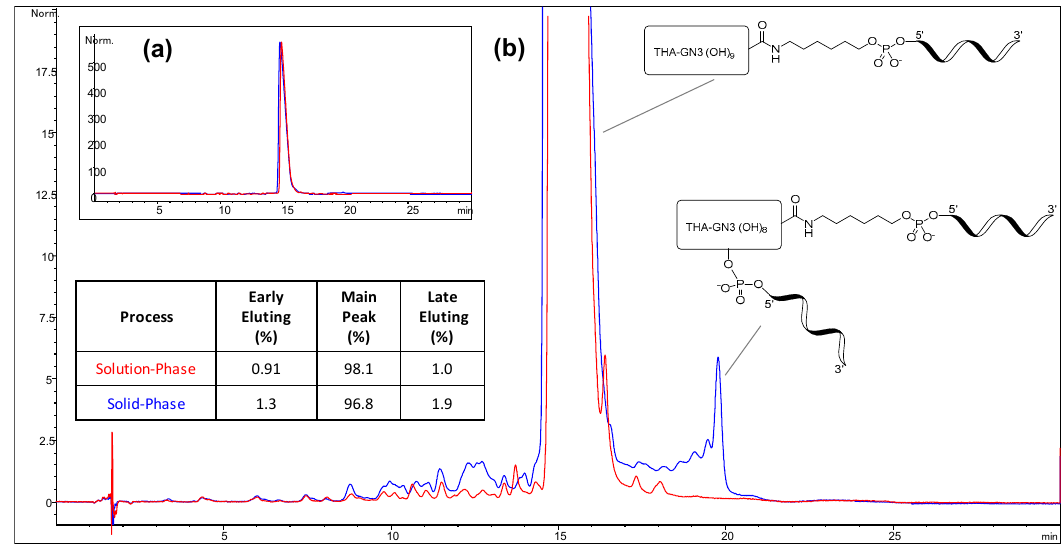
Figure 6. IP-HPLC-UV chromatograms for isolated GalNAc-conjugated ASOs from the solution-phase process (red) and the solid-phase process (blue). ( a ) Full-view chromatograms; and ( b ) zoomed-view chromatograms.